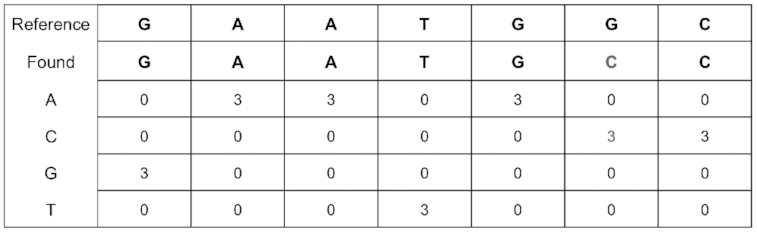
Table showing how the coverage profile is represented within iGenomics, summarizing how the reads align to the reference genome (an example of reads aligned to a reference genome is shown in Fig. 1). As can be seen in the sixth column, there is a mutation where the base C was found when the reference was base G.